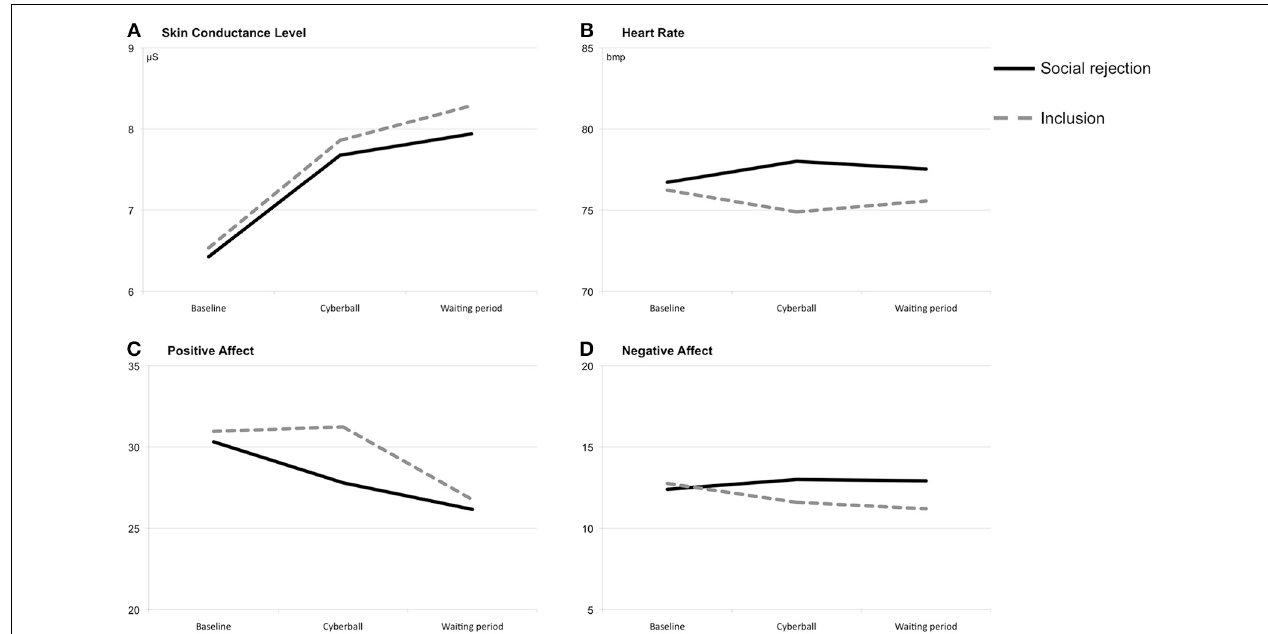
FIGURE 1 | Means at baseline, during/after the Cyberball game and during/after the waiting period. Note: Total scores of the positive and negative affect scales range from 10 to 50. (A) Means of skin conductance level (at baseline, during/after the Cyberball game and during/after the waiting period). (B) Means of heart rate (at baseline,